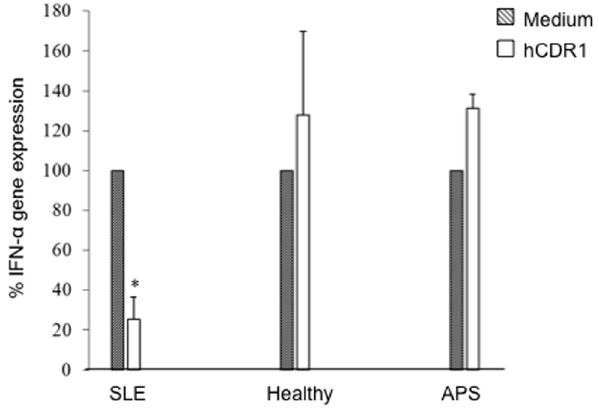
Figure 3. hCDR1 down regulates IFN- a gene expression in PBMC of SLE patients. PBMC of 10 SLE, 5 primary APS patients and 5 healthy controls were cultured (5 6 10 6 cells/well) for 48 hours in the presence of medium or hCDR1 (25 m g/ml). Gene expression was determined by real-time RT-PCR. Results are presented as the mean 6 SE percentage of gene expression compared with cultures with medium (considered as 100%). * p=0.004.